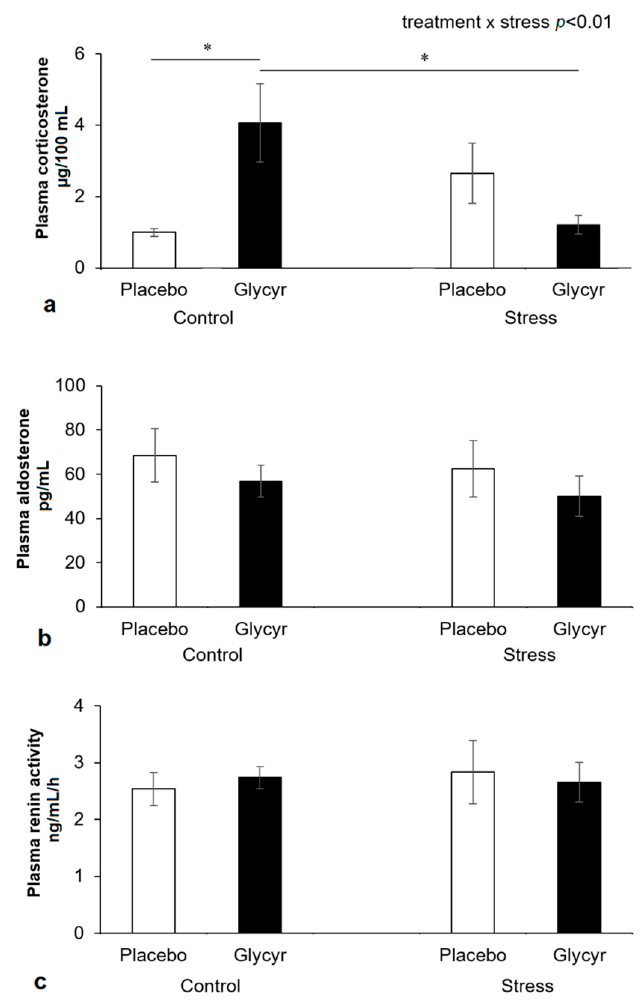
Figure 2. Concentrations of plasma corticosterone ( a ), concentrations of plasma aldosterone ( b ) and plasma renin activity ( c ) in rats treated with Glycyrrhiza glabra extract or placebo with or without exposure to chronic mild stress. Each value represents the mean ± standard error of the mean (SEM) ( n = 12 rats/group). Statistical significance as revealed by two-way ANOVA followed by Tukey post-hoc test: * p < 0.05.